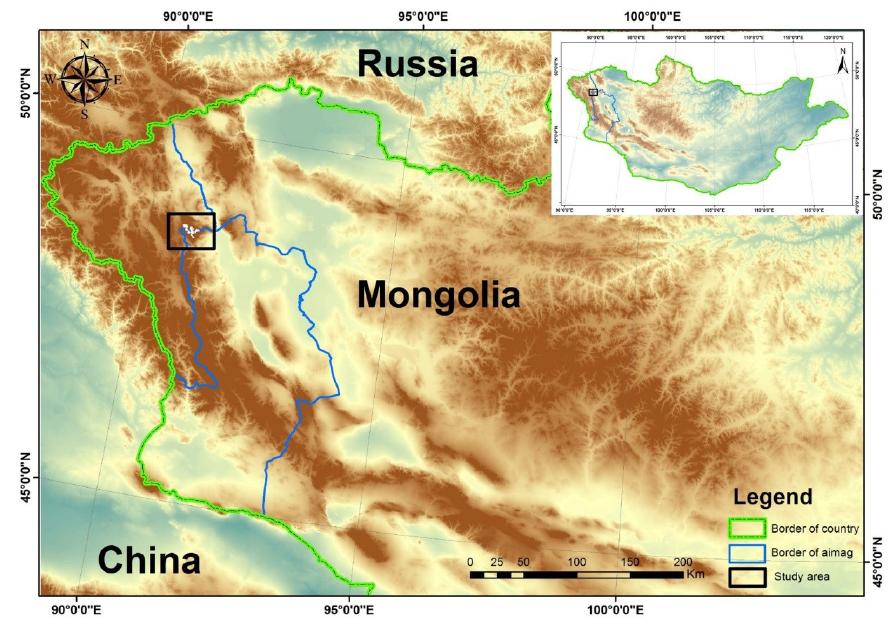
Fig. 1. Geographical location of Mt. Tsambagarav in the Mongolian Altai Mountain Range in western Mongolia.